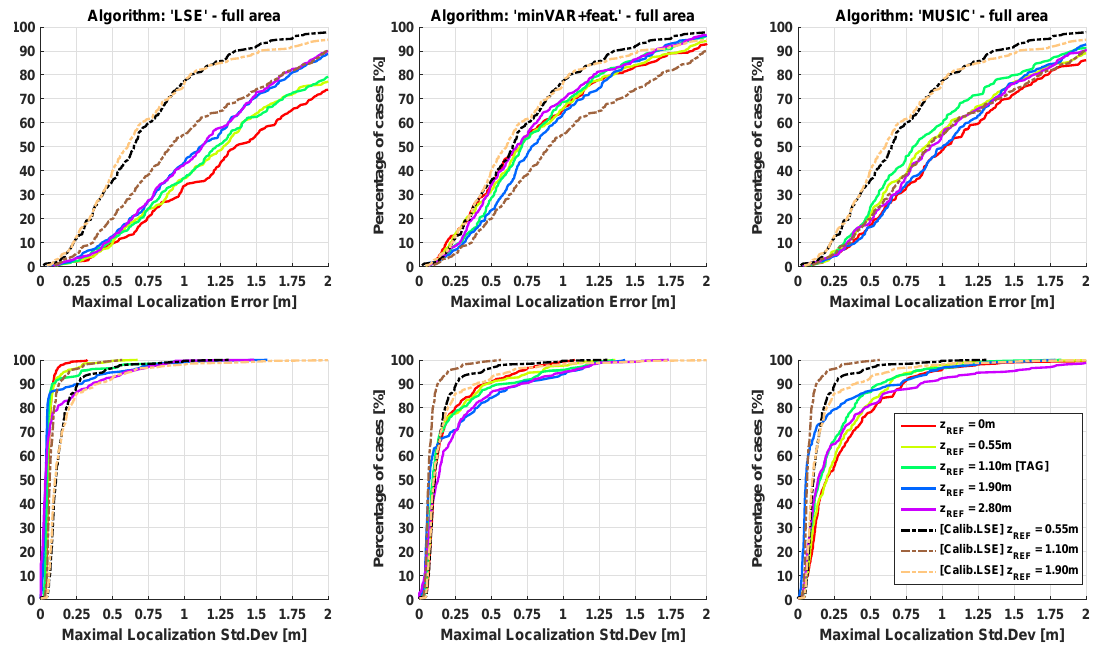
Algorithm: 'minVAR+feat.' - full area Algorithm: 'MUSIC' - full area